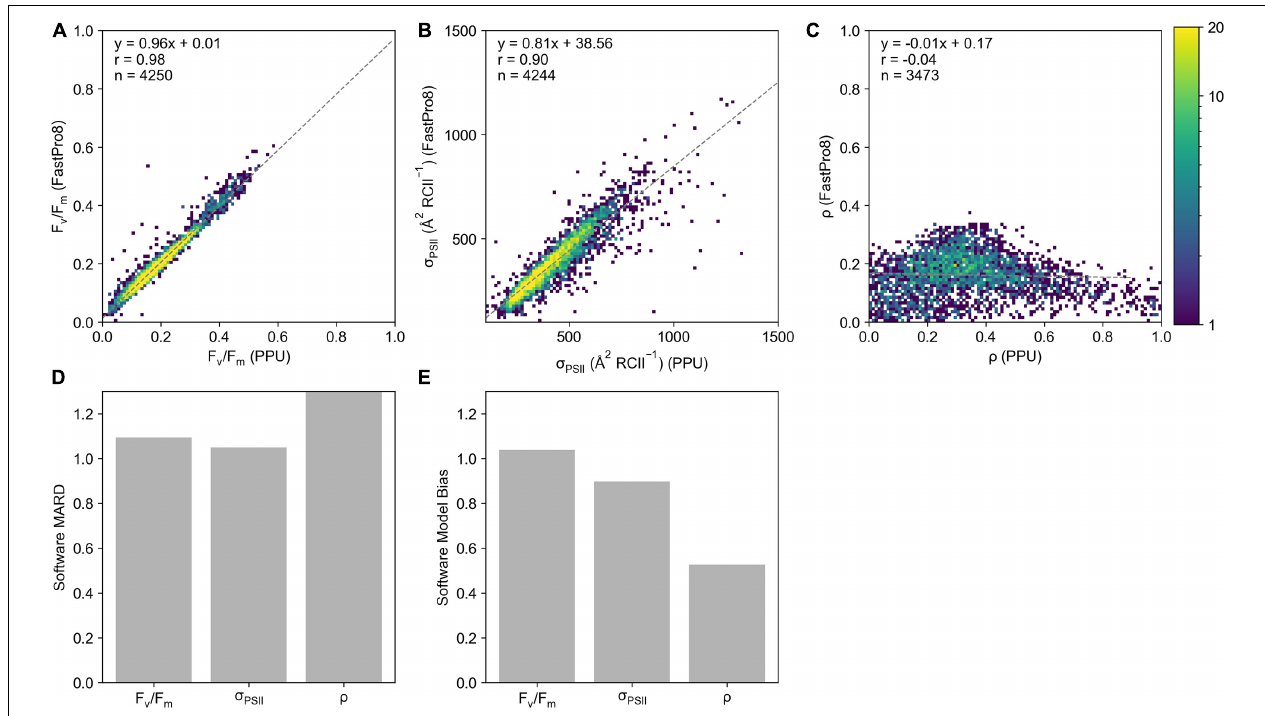
◦ FIGURE 5 | A 2D histogram of F v /F m (A) , σ PSII ( A 2 RCII − 1 ) (B) , and ρ (C) from the FastPro8 software (y-axis) versus PPU (x-axis) processing of FAST Ocean data from the South Pacific (IN2016_T01). Bar charts of (D) software MARD (%) and (E) software model bias calculated between FastPro8 and PPU. Note that the Software MARD for ρ in panel (D) is out of the axis